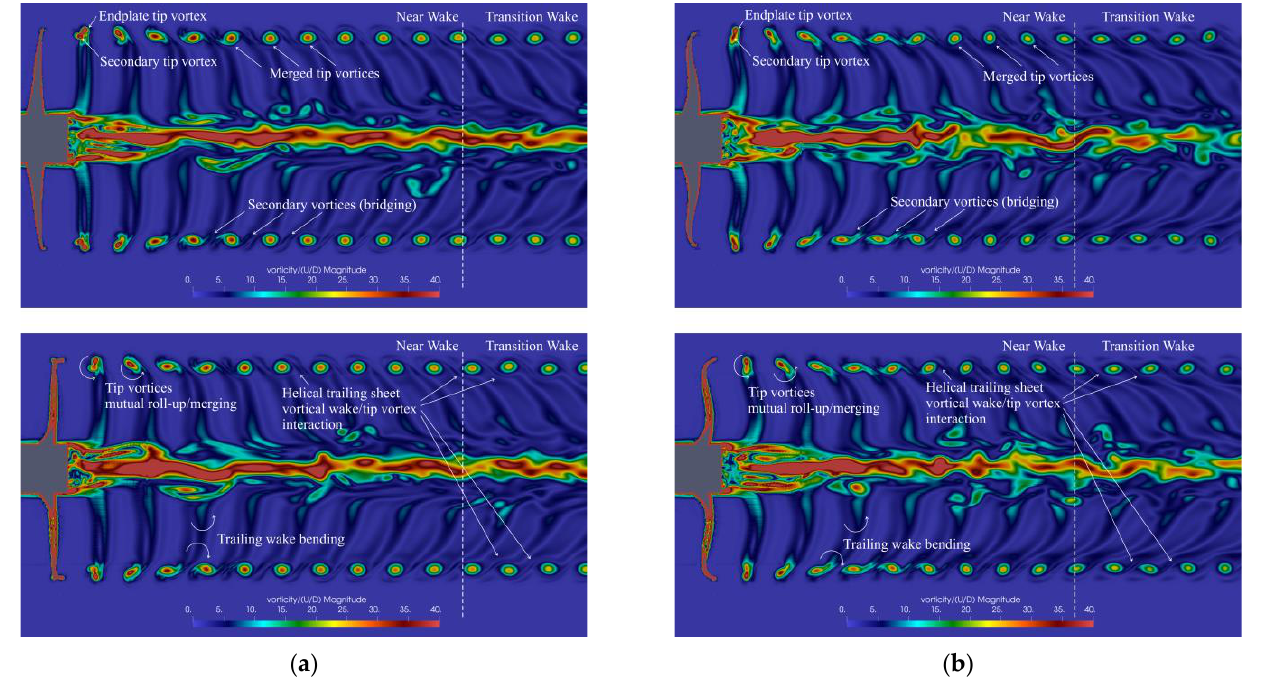
Figure 14. Longitudinal distribution of vorticity (magnitude) at time t (top) and t + 80 deg. (bottom). Design advance coefficient ( J = 0.9). ( a ) Conventional CLT propeller; ( b ) New generation CLT propeller.